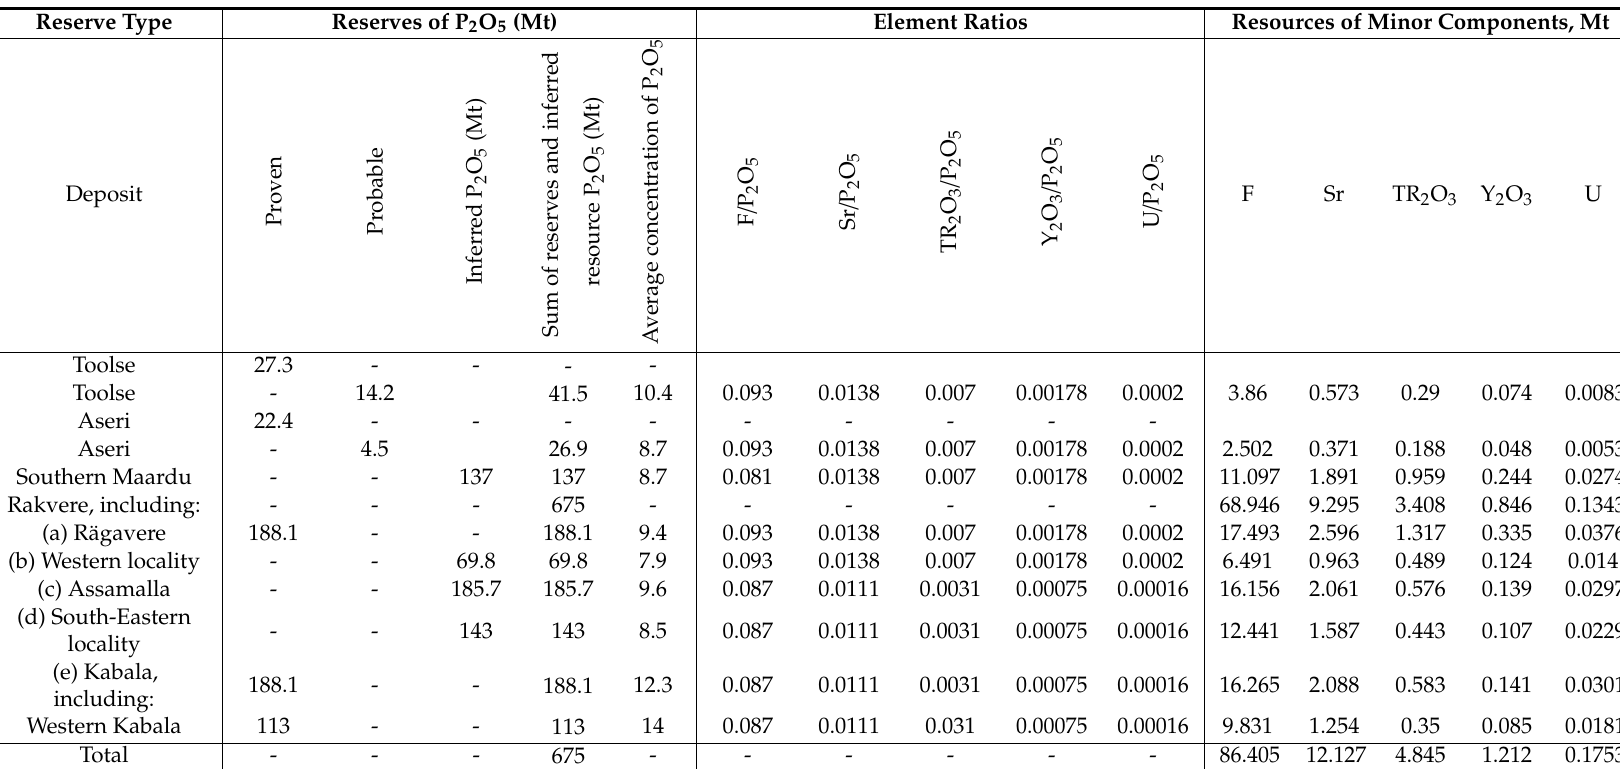
Table A1. Phosphorite ( P 2 O 5 in Mt ) and associated element resources in di ff erent Estonian deposits. Adapted from reference